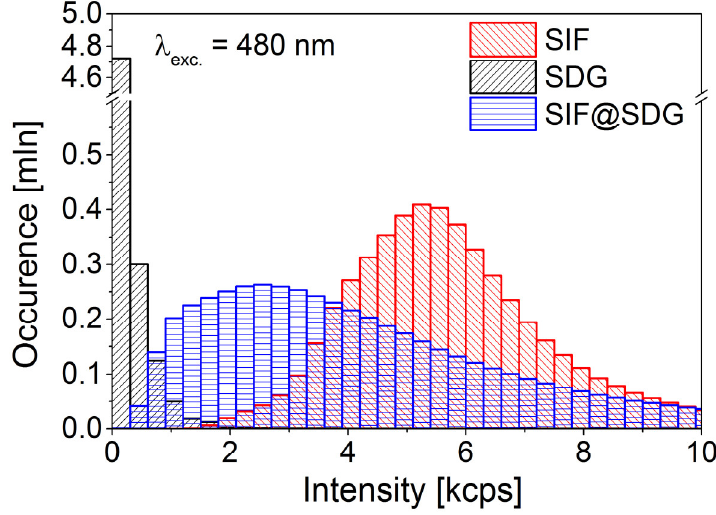
Figure 2. Fluorescence intensity histograms obtained from 10 maps measured for each studied sample: PCP on SIF (red), PCP on SDG (black), and PCP on SDG@SIF (blue). The excitation wavelength was 480 nm.